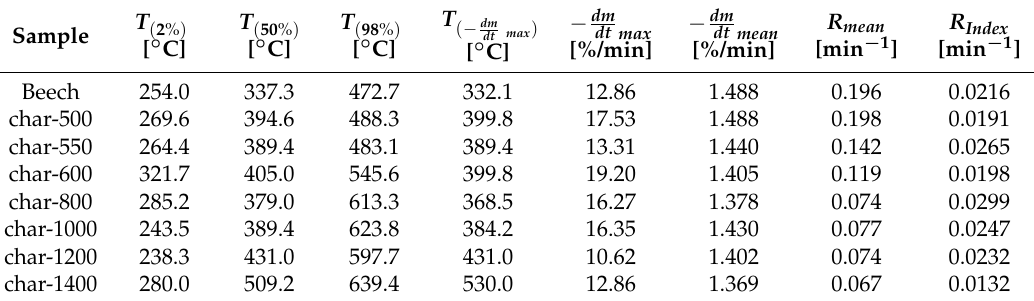
Table 4. Characteristics of the char TG oxidation experiments. Table 5. Characteristics of the char TG oxidation